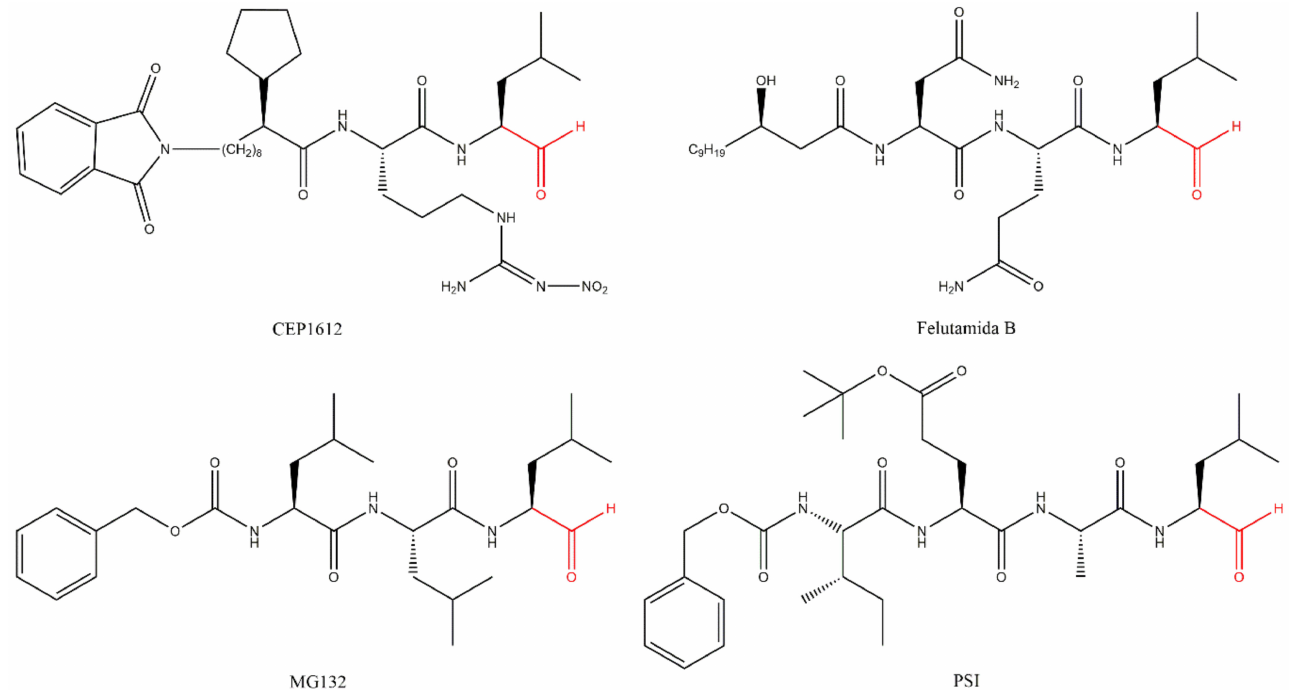
Figure 7. Examples of aldehydes inhibitors of 20S CP